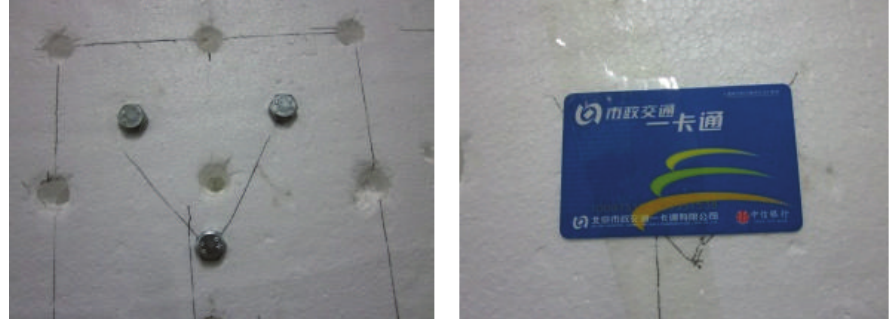
Figure 6: Photo of three screws and a